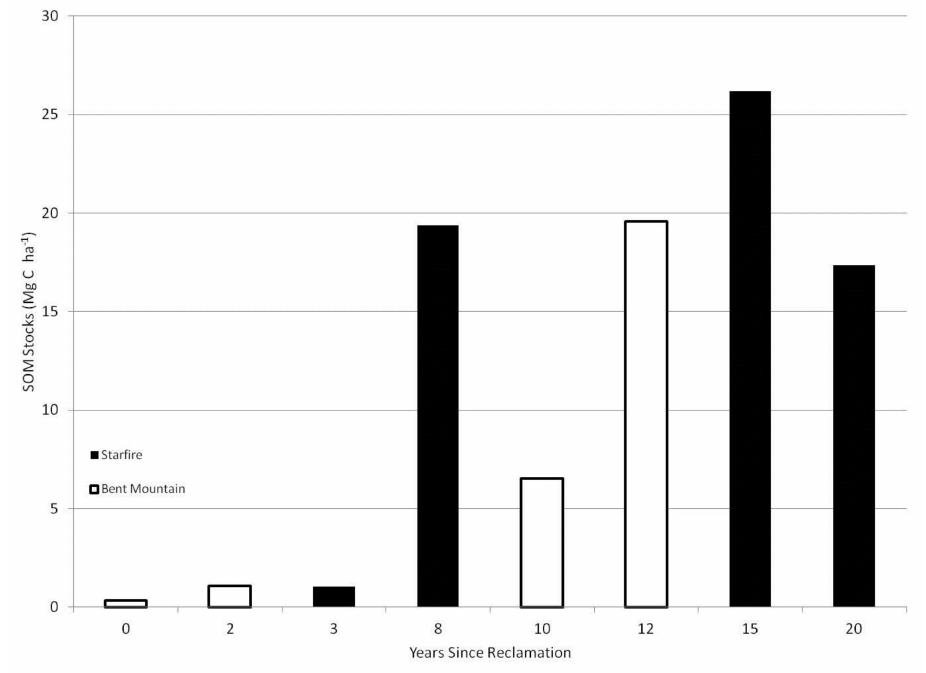
Figure 8. SOM stocks in mine soils over time since reclamation. Rates of accumulation of SOM in Bent Mountain sites appeared to lag slightly behind those of Starfire Mine sites.